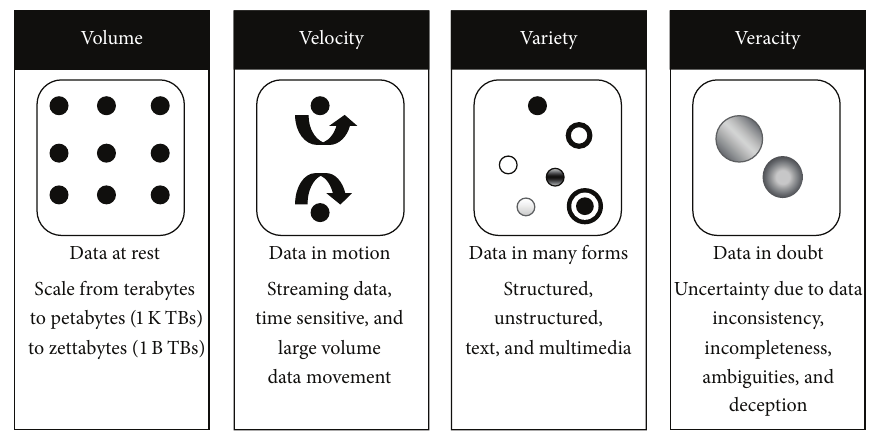
Figure 1: 4Vs of Big